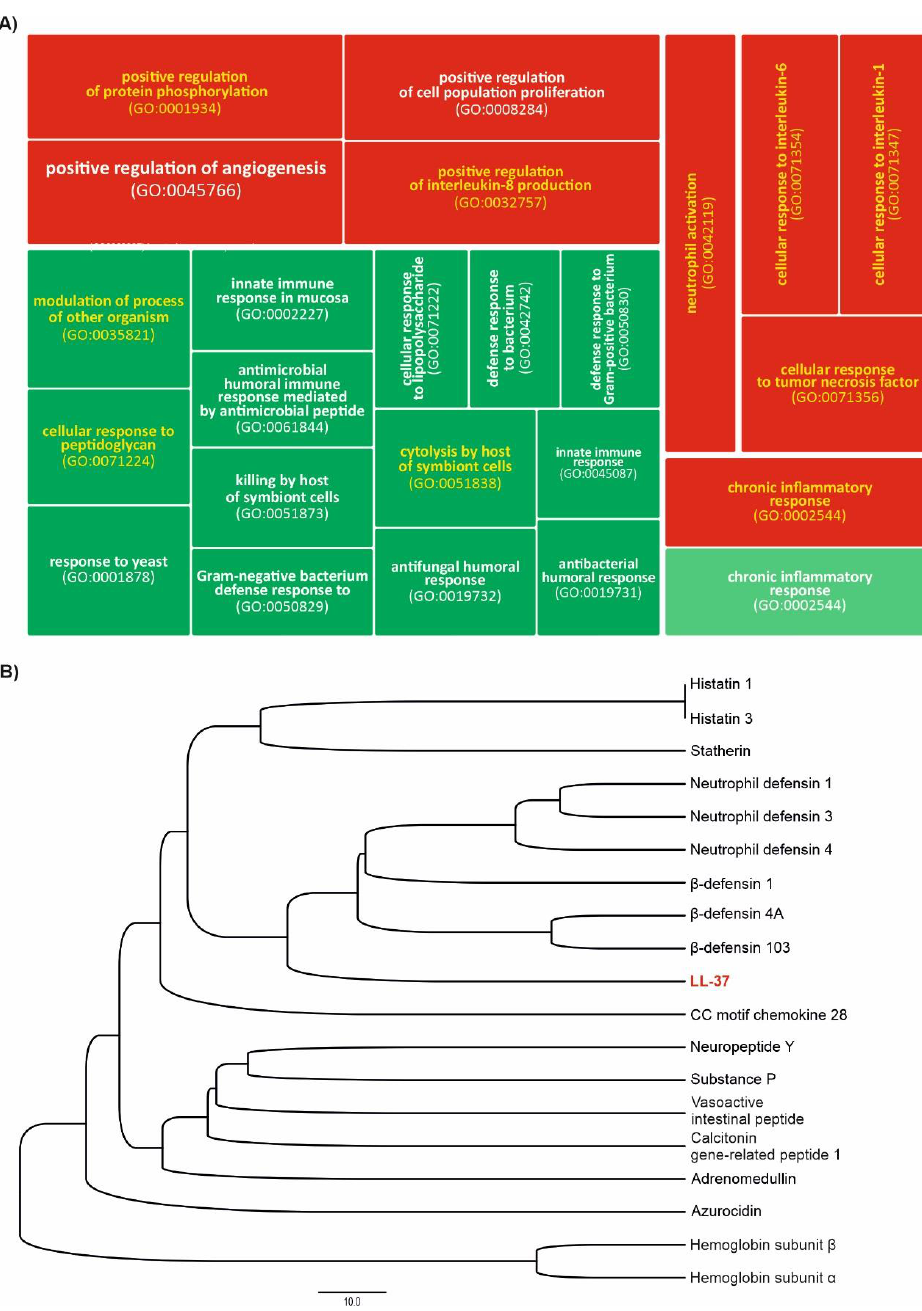
Figure 2. Tree map of the Biological Process (BP) Gene Ontology (GO) category for human cathelicidin LL-37 (panel A ); green and red boxes show processes associated with immune responses against microorganisms and immunomodulatory action, respectively. Functional similarity of 20 human cationic antimicrobial peptides (CAMPs) present in the oral cavity inferred from comparing their Biological Process (BP) Gene Ontology (GO) category (panel B ); the BPs unique for human cathelicidin LL-37 are indicated by yellow color in panel A. The dendrogram was constructed using Dice coefficient and UPGMA clustering with NTSYSpc software ver. 2.1 (Exeter Software) based on the GOs collected from the QuickGO server (www.ebi.ac.uk/QuickGO/).